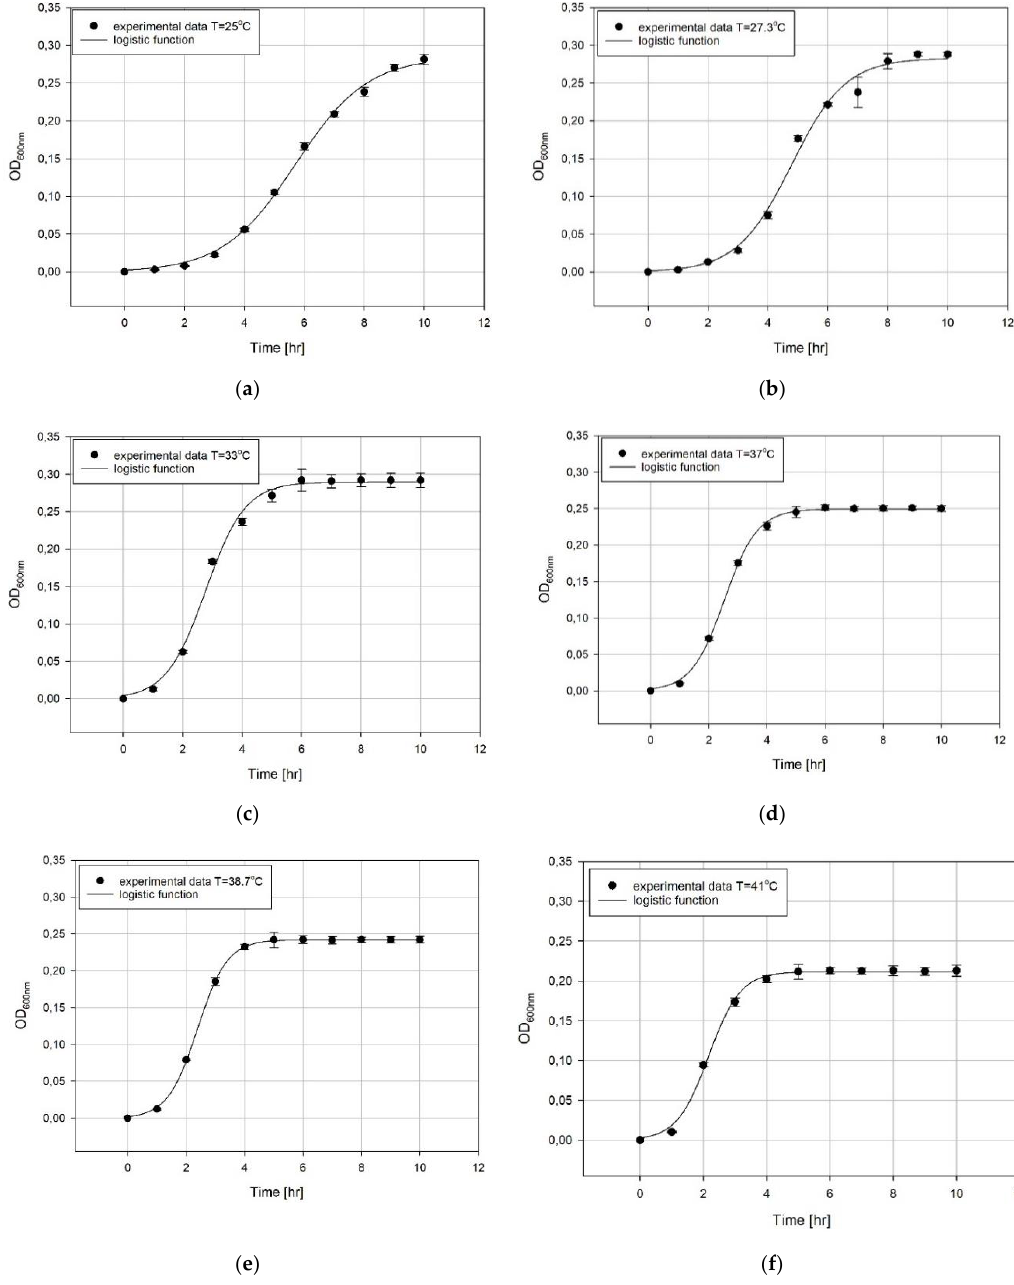
Figure 4. The growth of K. pneumoniae in various temperatures: ( a ) T = 25 °C, ( b ) T = 27.3 °C, ( c ) T = 33 °C, ( d ) T = 37 °C, ( e ) T = 38.7 °C, ( f ) T = 41 °C. Table 2. Growth curve model function coe ffi cients in selected